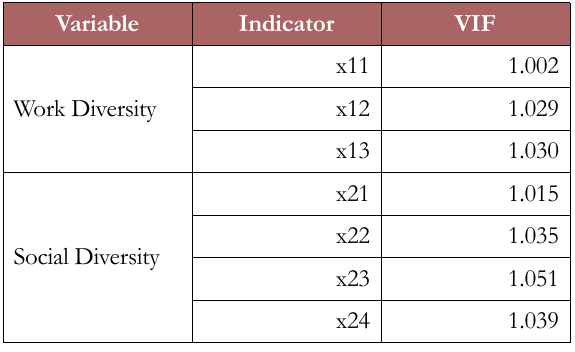
Table 9 . Multicollinearity Test for Formative Indicators